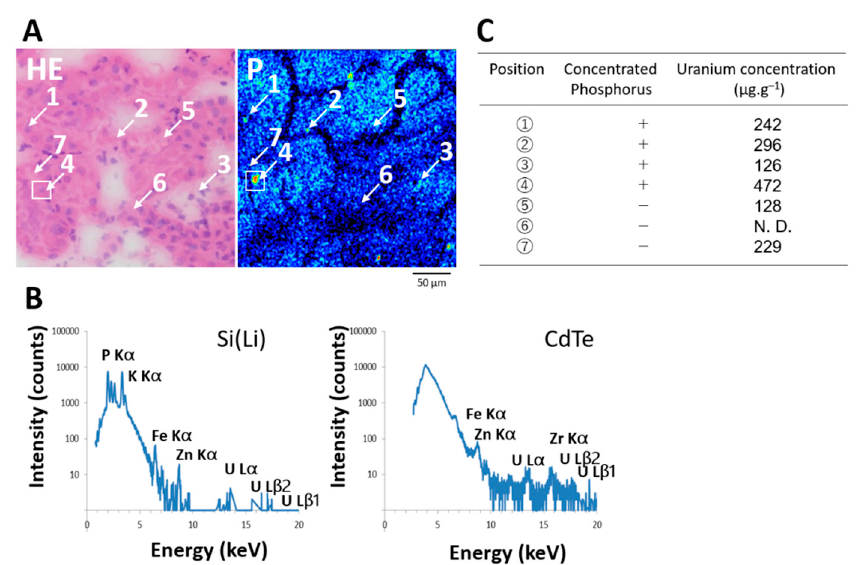
Figure 5. Quantitative local analysis of uranium in areas with and without concentrated phosphorus in the S3 segments of the proximal tubules on day 1 post-administration of UA (2 mg kg − 1 ). ( A ), Analytical points for PIXE with microprobe ( µ -PIXE) spot analysis (scanned area, 500 µ m × 500 µ m; integrated current, 0.2 µ C; beam size, 1 µ m × 1 µ m). Points 1–4 and 5–7 with and without concentrated phosphorus, respectively. HE, hematoxylin and eosin. P, phosphorus imaging (scanned area, 250 µ m × 250 µ m; integrated current, 0.2 µ C; beam size, 1 µ m × 1 µ m). ( B ), µ -PIXE spectra of boxed area ( A ) (scanned area, 30 µ m × 30 µ m; integrated current, 0.2 µ C; beam size, 1 µ m × 1 µ m) with Si (Li) and CdTe detectors.